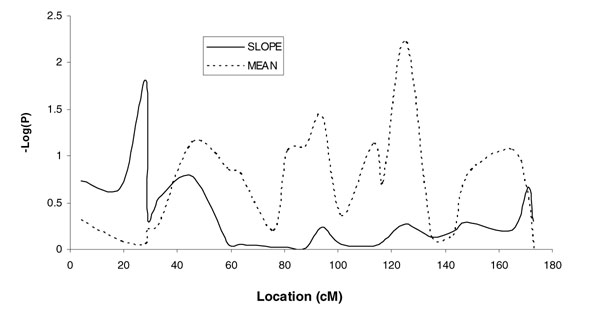
Linkage profiles for two longitudinal summary measures Lines depict the -log10 (P-value) along chromosome 10. The dashed line indicates the arithmetic mean and the solid line indicates the temporal slope of longitudinal systolic blood pressures. The results were obtained by new Haseman-Elston regression using SAGE package.